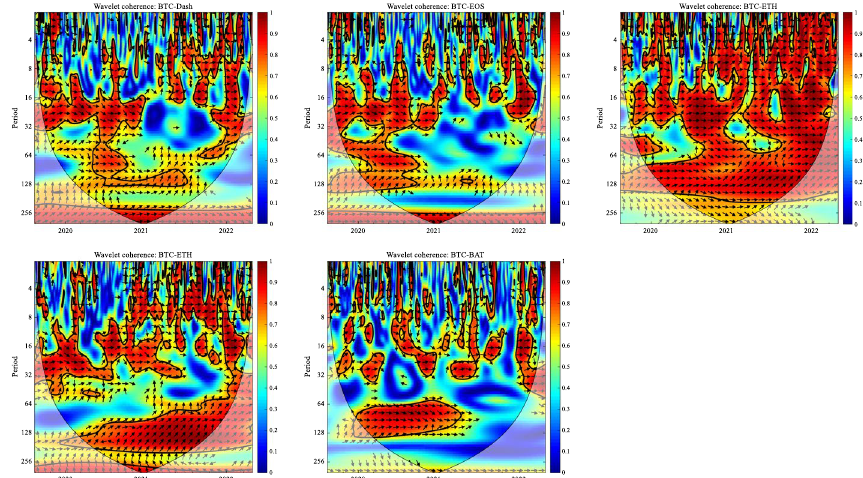
Fig. 3 Wavelet coherence—realized volatility (RV)